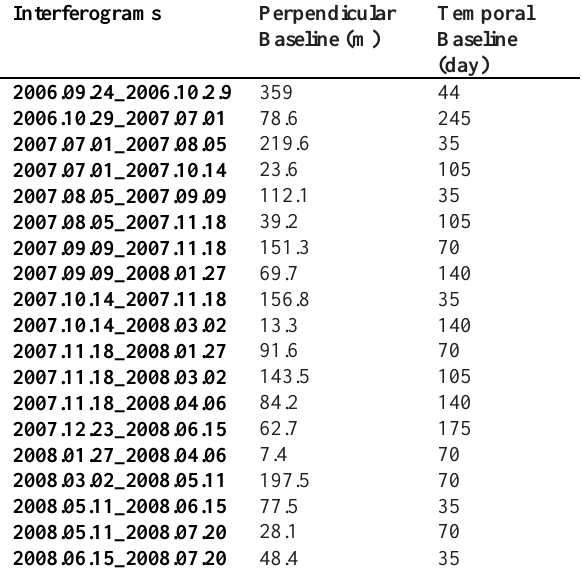
Table. 1 . Constructed interferograms with the spatial and temporal baselines .